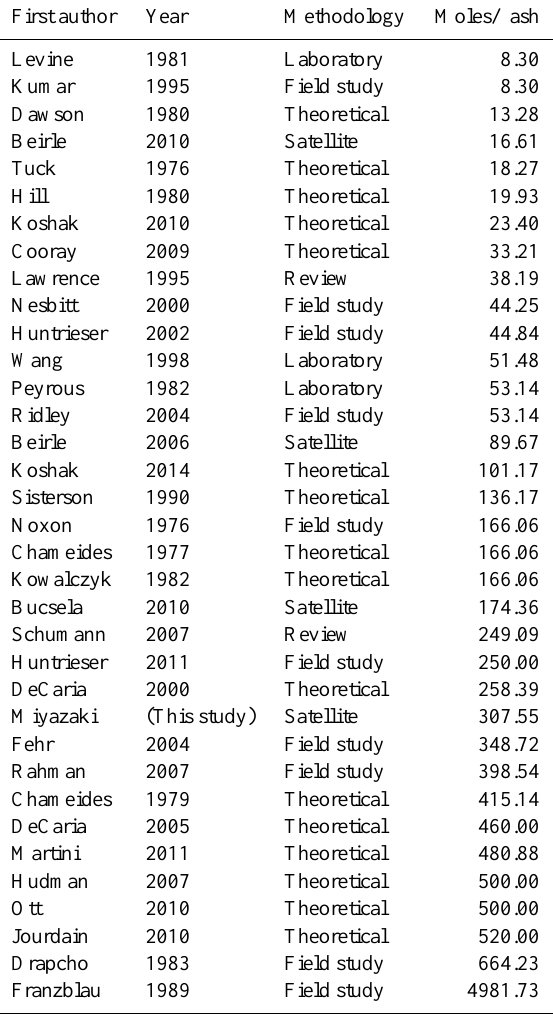
Table 8. A comparison of estimates of NO x amount produced per flash (molNOflash − 1 ), adapted from Peterson and Beasley (2011) and Koshak et al.